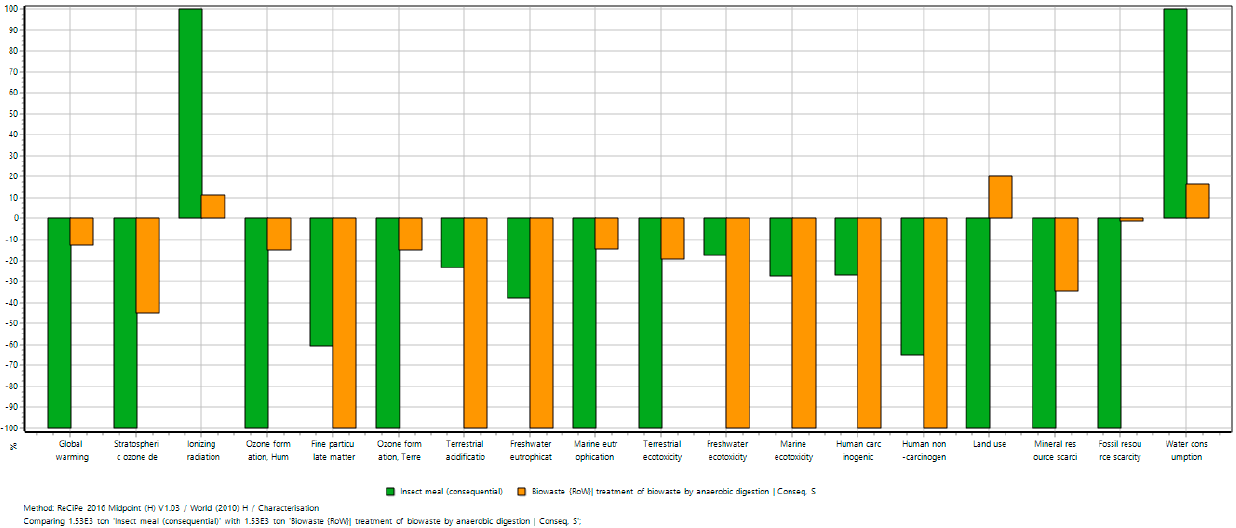
Figure 5 . Comparison of the environmental impact of both scenarios . Figure 5. Comparison of the environmental impact of both